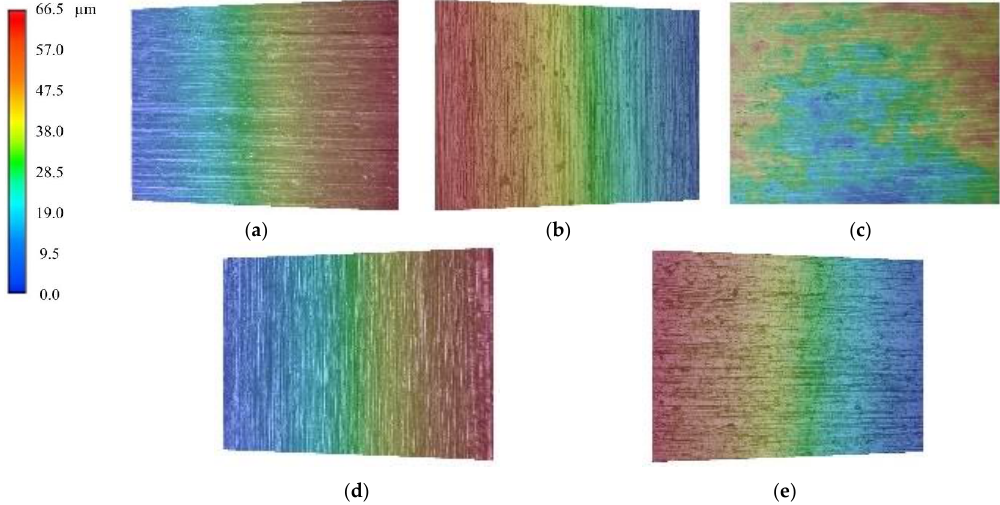
Figure 21. The surface appearance of five regions before processing: ( a ) L1, ( b ) L2, ( c ) L3, ( d ) L4, ( e ) L5.